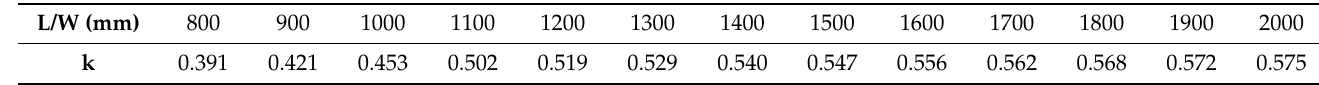
Table 2. Coupling coefficient under different coil sizes.